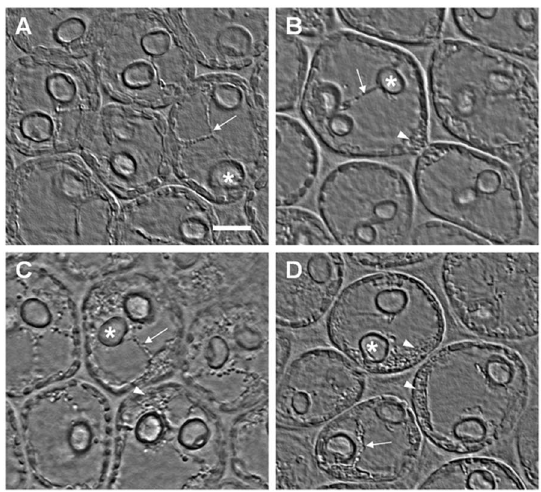
Figure 4. Alga cells treated with colchicine. (A) Control, (B) 0.15 mM colchicine, (C, D) 1.5 mM colchicine.*= CC , arrows=connec- tions structures, arrowheads=vesicles. Note the progressive accumu- lation of vesicles in the cell periphery (C, D) and the high accumulation of vesicles close to intercellular connections (B,D). Bar=10 m m.